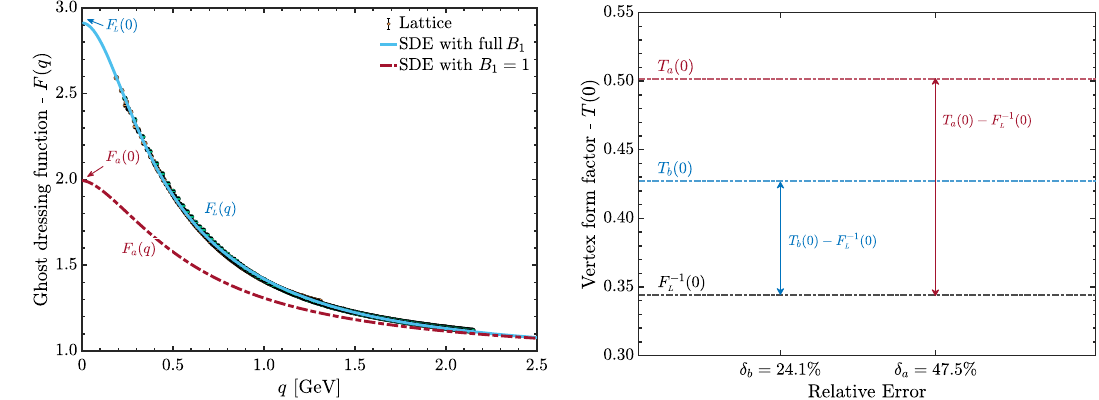
Fig. 9 Leftpanel:Latticedatafortheghostdressingfunctionfrom[60] (circles), together with SDE results using the full B 1 (blue continuous curve) or its tree-level value (red dashed curve). Right panel: Compar-